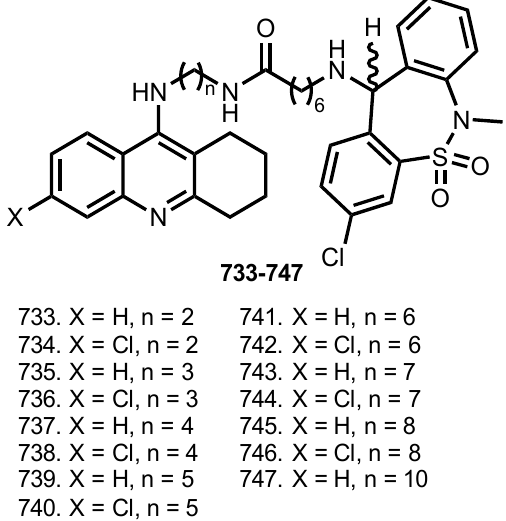
Figure 30. THA–Tianeptine hybrids 733 – 747 [110].